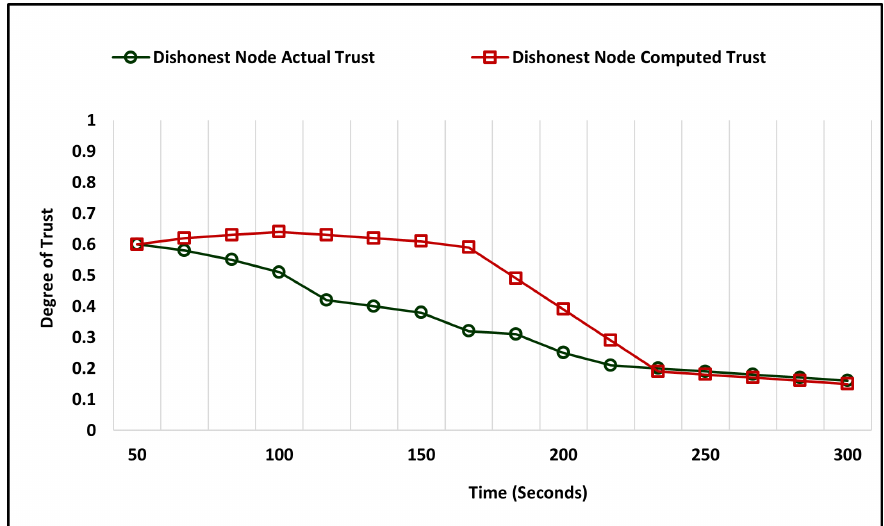
Figure 5. Dishonest node’s trust degree